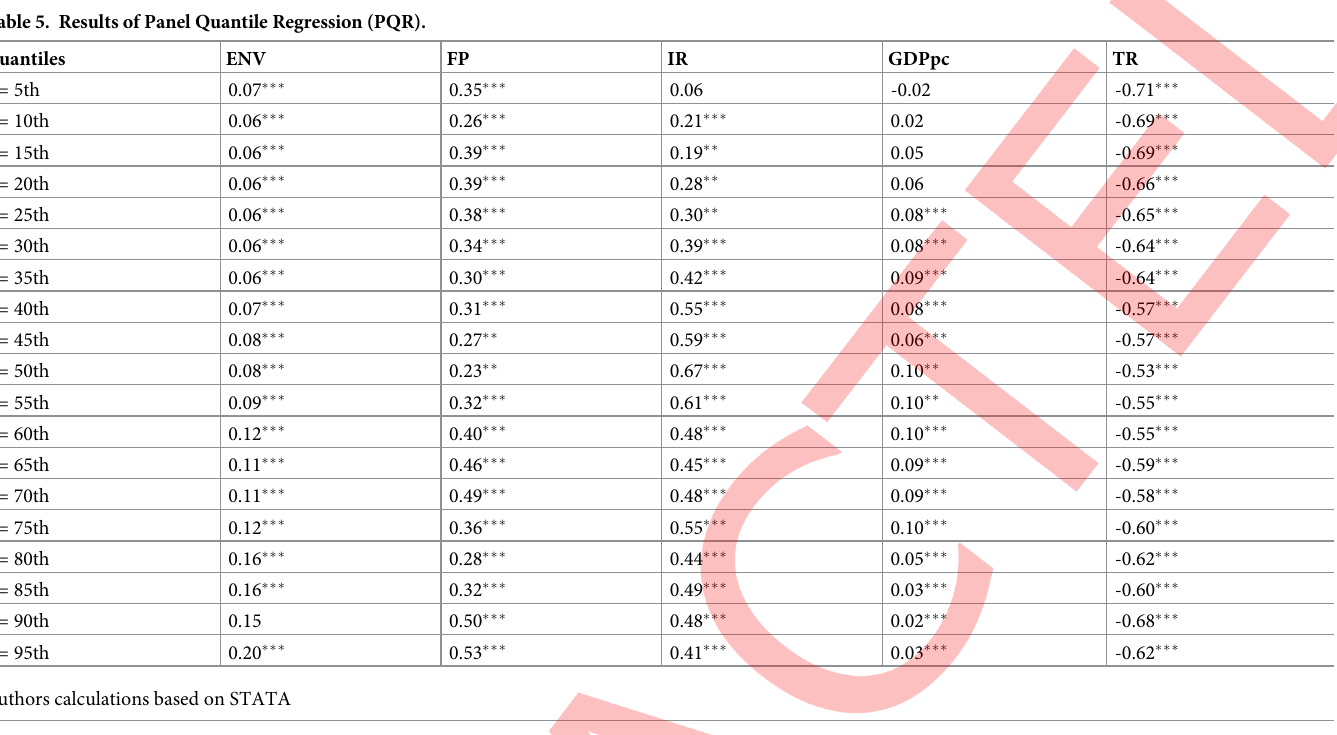
Table 5. Results of Panel Quantile Regression (PQR).